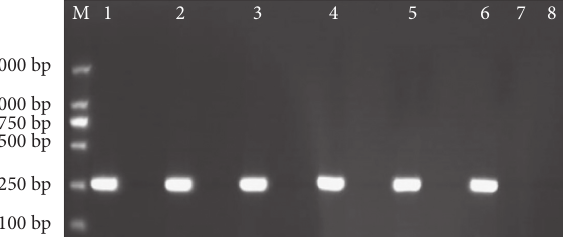
Figure 9: The PCR analysis of the long-term test of genomic DNA reference materials for 8 months. M , DNA marker D (100 ∼ 2000bp); lanes 1–3, PCR results of 3 samples stored at − 20 ° C, respectively; lanes 4–6, PCR results of 3 samples stored at 4 ° C, respectively; lane 7, negative control; and lane 8, blank